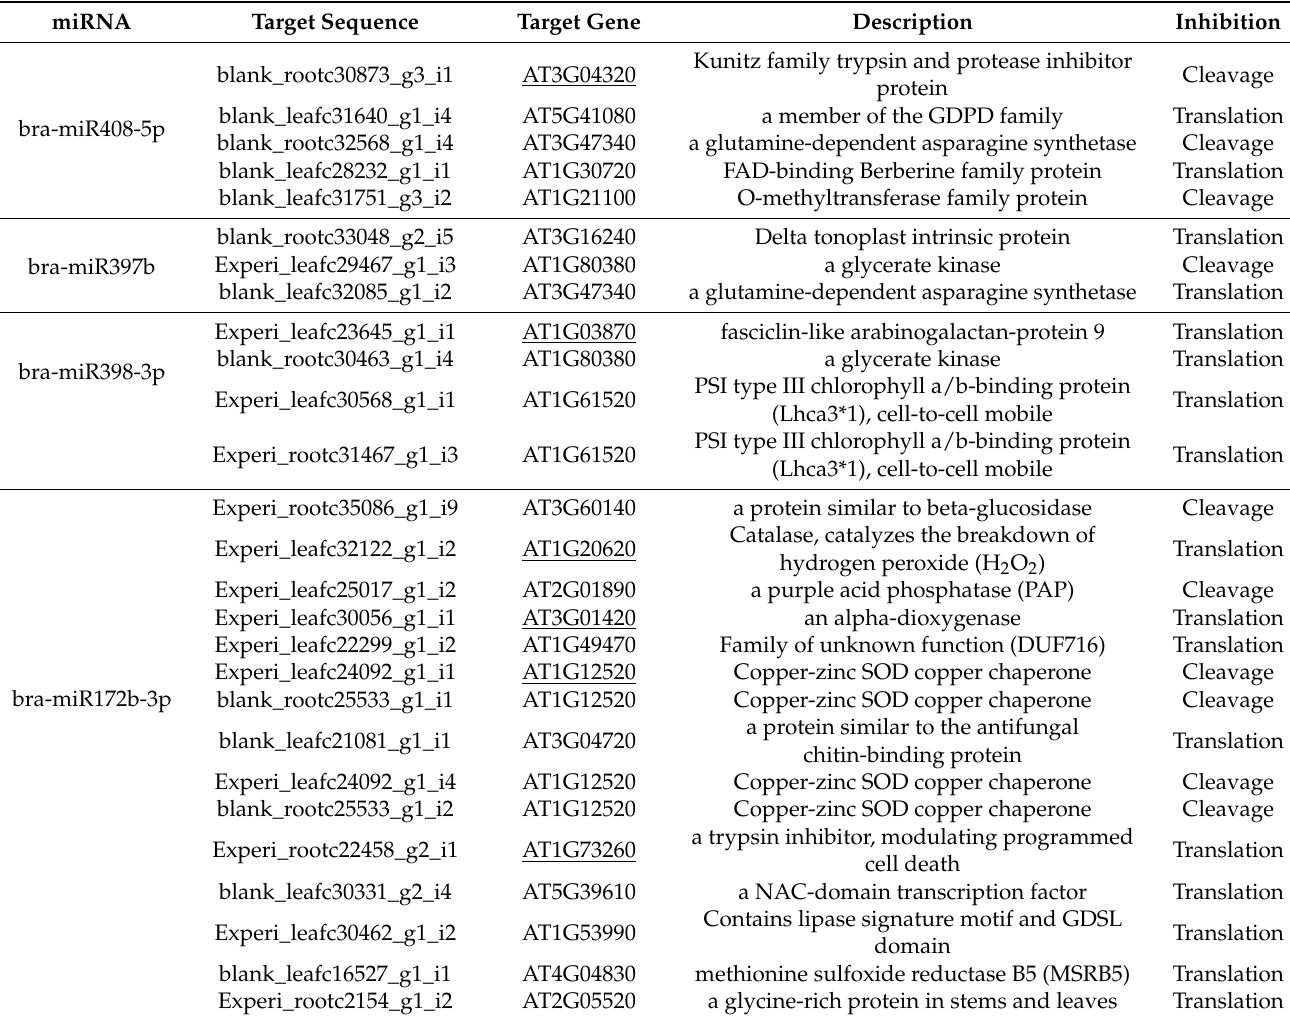
Table 4. Identified target genes for conserved miRNAs in Brassica juncea